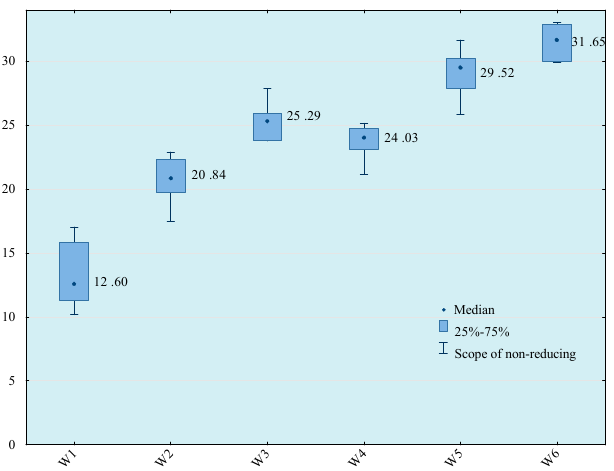
Figure 5. Tensile strength of E57/Z-1/CaCO 3 /100:10:20 composition depending on the mixing method.